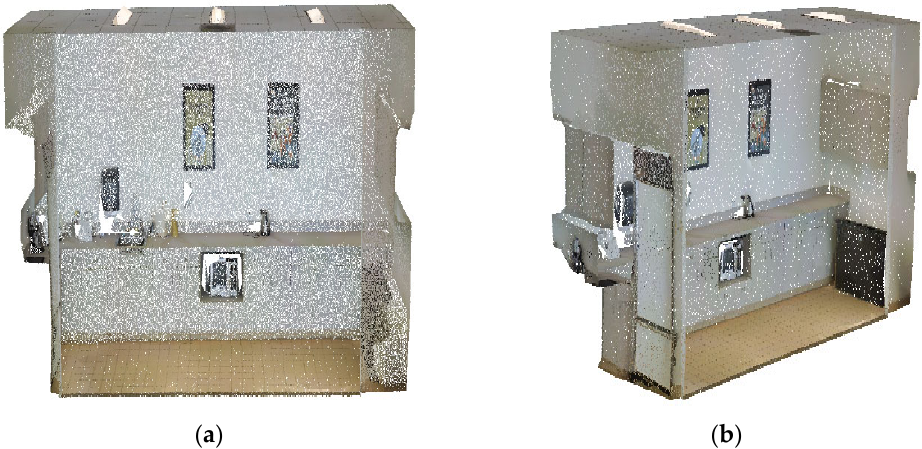
Figure 6. Raw point cloud data of the pantry: ( a ) front view and ( b ) side view.